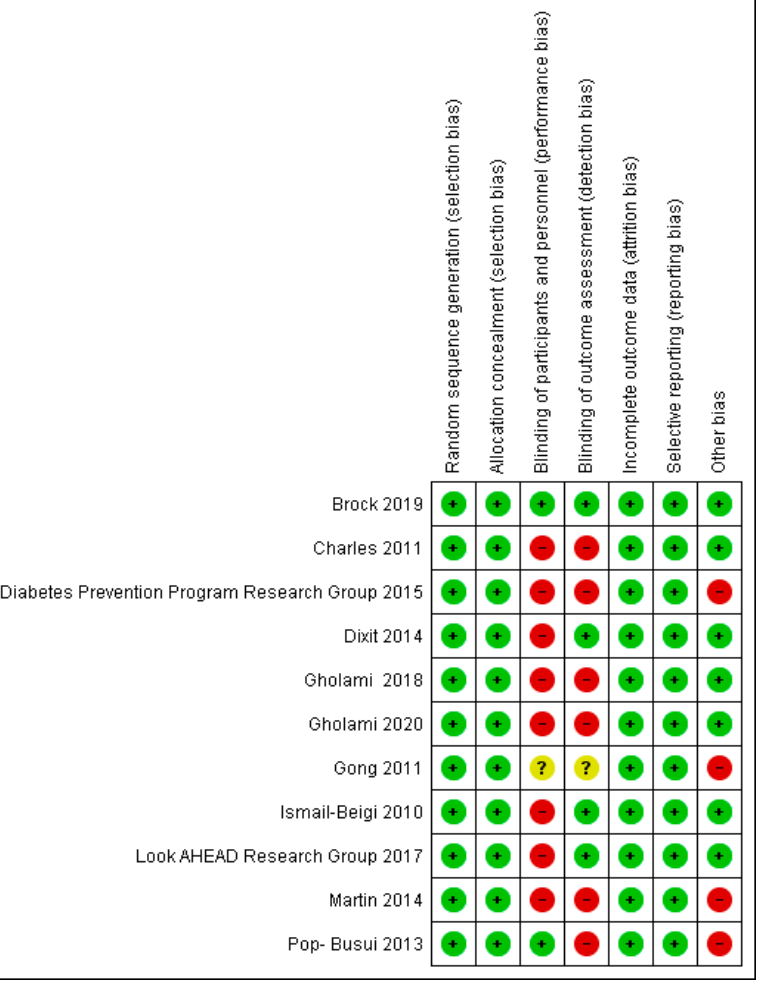
Figure 3. Risk of biases of the included studies [15,53–62], individual analysis. Green: low risk, yellow: unclear risk, red: high risk.